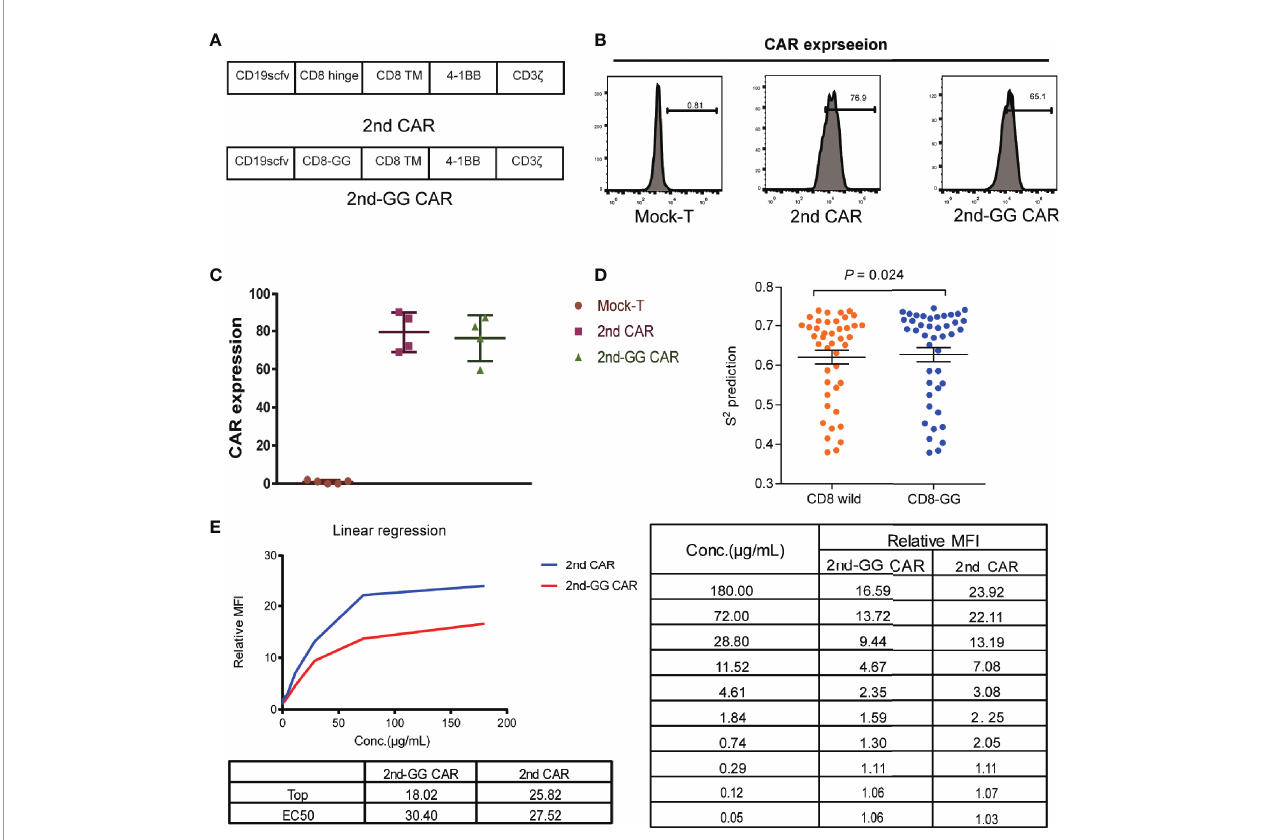
FIGURE 1 | Schematic diagram and expression ef fi ciency of 2nd and 2nd-GG CAR-T cells. (A) Diagrammatic model of 2nd and 2nd-GG CAR. Schematic of CAR containing scfv (FMC63), variations in the hinge, extra-membrane, and transmembrane domains. The hinge region of 2nd-GG deleted two Gly compared with that of the 2nd CAR, and the rest of the sequences were the same. (B) Typical fl ow cytometry detection of the expression ef fi ciency of 2nd and 2nd-GG CAR on T cells. (C) Expression ef fi ciency of 2nd and 2nd-GG on T cells 5-6 days after culture in vitro determined by fl ow cytometry (mean ± SD, n = 5). T cells are derived from at least three different healthy donors. (D) . Comparison of the fl exibility between the CD8 hinge and the CD8-GG hinge. S2 order parameter (S2 RCI) values were estimated from chemical shift values using the Random Coil Index (RCI) software. S2 is inversely proportional to the hinge region fl exibility. (E) . The af fi nity of CD19 protein to different CAR T cells: 2nd CAR-T cells > 2nd-GG CAR-T cells. The EC50 of 2nd and 2nd-GG CAR-T cells binding to CD19 protein was determined by fl ow cytometry. EC50, 50% maximal effective concentration. CAR, chimeric antigen receptor; FITC, fl uorescein